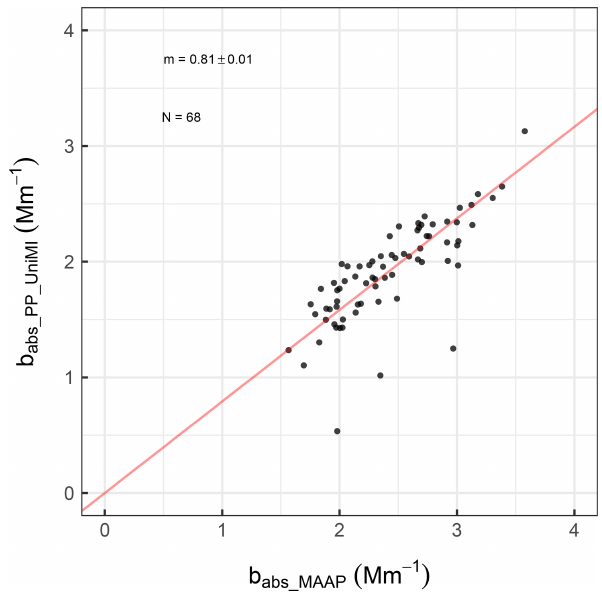
Figure A1. Comparison between the aerosol absorption coefficient measured by PP_UniMI on sample spots ( σ ap_PP_UniMI ) and the MAAP ( σ ap_MAAP